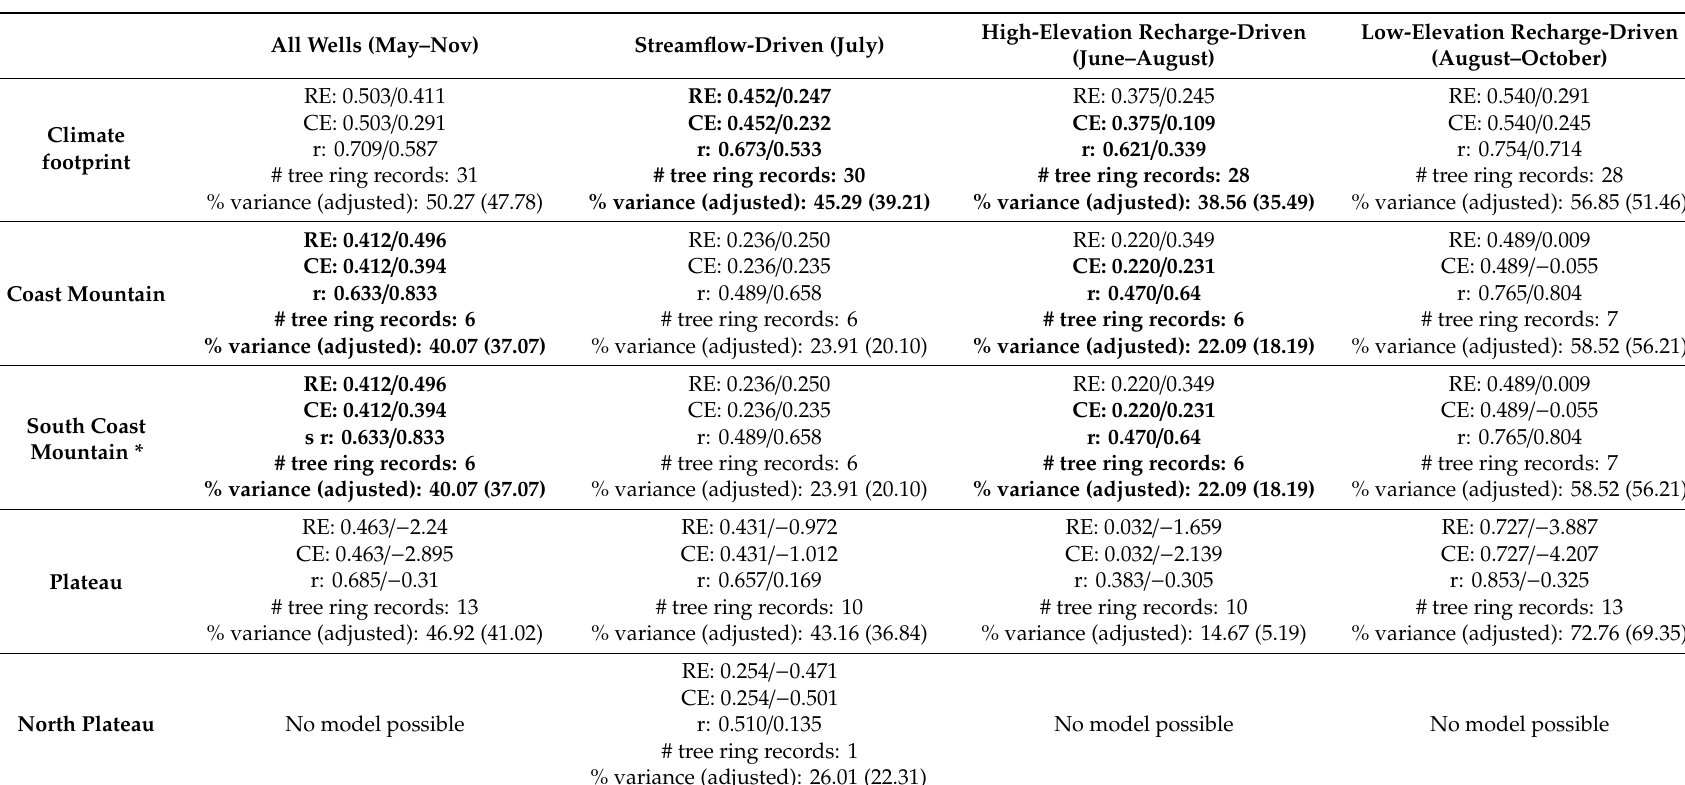
Table 1. Model statistics for the 28 model simulations tested using varying recharge mechanisms and varying spatial areas used to select potential tree ring records to be used in the models. All the reconstructions cover the time period 1900–2004. The reduction of error (RE) and coe ffi cient of e ffi ciency (CE) statistics and Pearson’s r are shown for the calibration and validation periods (calibration / validation) when calibration was performed on the first two-thirds of the overlap period. Percent variance is shown for the calibration period, with the percent variance values adjusted for the number of degrees of freedom shown in brackets. Models that have positive ( > 0) RE and CE statistics when calibration was performed on both the early two-thirds and the later two-thirds of the overlap period are shown in bold (i.e., they are